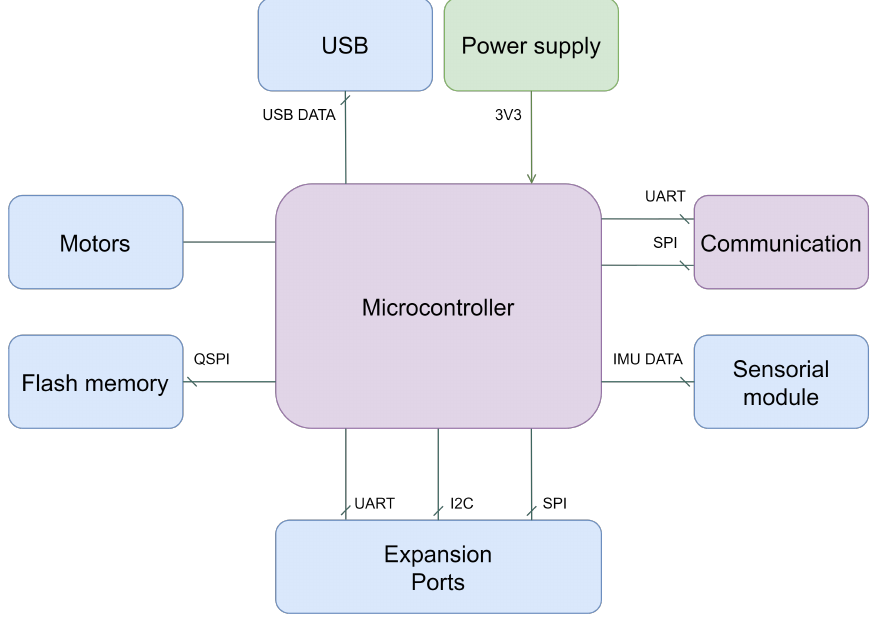
Figure 2. High-level diagram of the